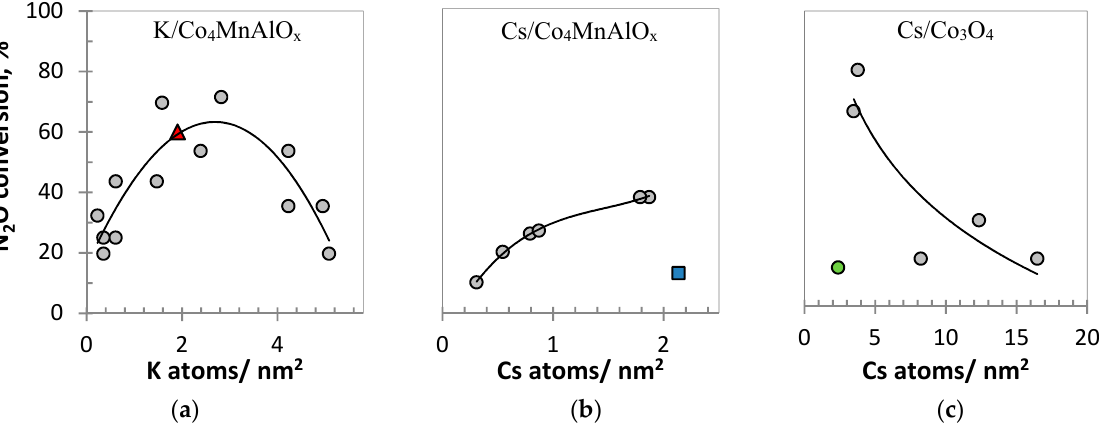
Figure 7. Dependence of N 2 O conversion on alkali metal loading. Conditions: 1000 ppm N 2 O + 5 mol% O 2 + 2 mol% H 2 O in N 2 . Laboratory prepared catalysts. ( a ) 450 °C, GHSV